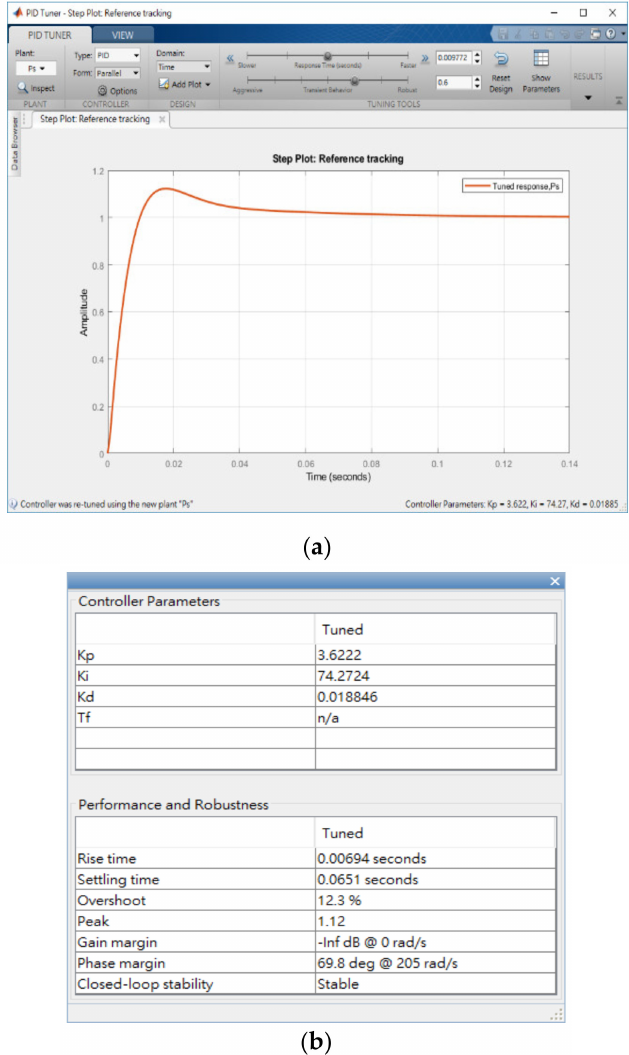
Figure 8. Proportional–integral–derivative (PID) tuner. ( a ) Step plot PID tuner and ( b ) PID value, performance, and